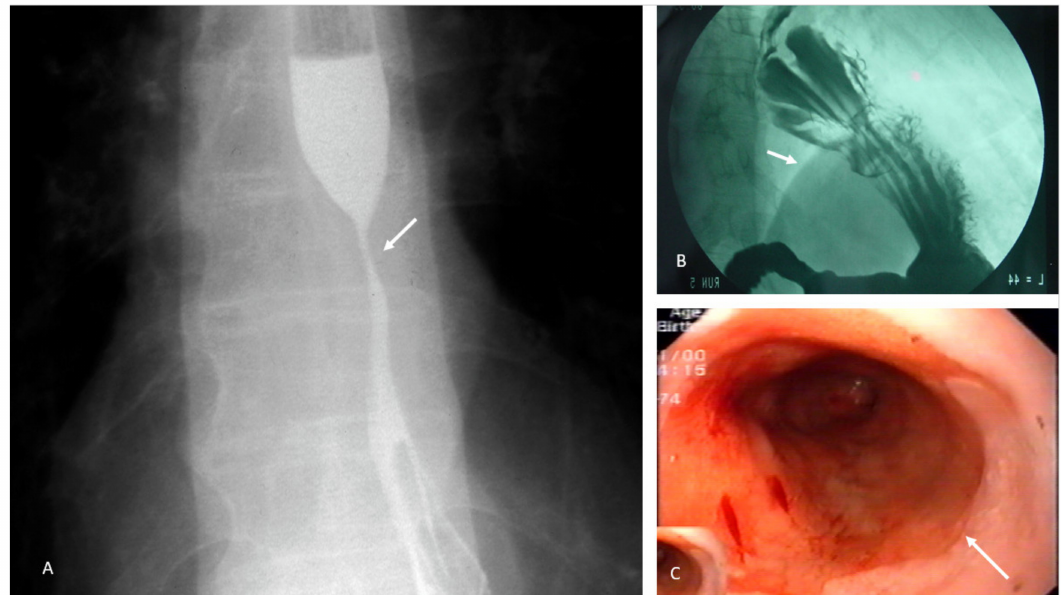
Figure 6. Images related to gastroesophageal reflux disease. ( A ) Filiform narrowing of the lumen of the middle one-third of the esophagus can be seen in a patient with long-standing gastroesophageal reflux symptoms. The stricture results from the reparative collagenization of peptic lesions caused by acid reflux. ( B ) Voluminous hiatal hernia. Note how a considerable proportion of the stomach extends beyond the diaphragm line (arrow). ( C ) Extensive area of salmon-colored mucosa that contrasts with the lighter coloration of the remaining esophagus, suggesting Barrett’s metaplasia. Note the transition between normal mucosa and intestinal metaplasia, and its length (long Barrett’s esophagus)